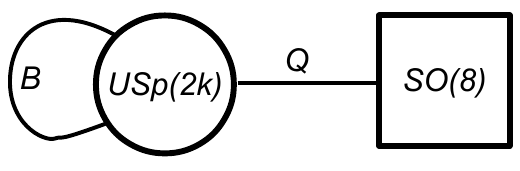
Figure 3 . 2d quiver corresponding to the H ( k )